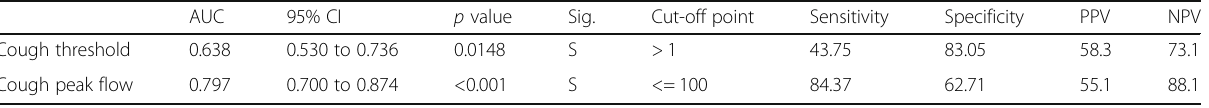
Table 4 ROC curve for threshold and peak flow of cough challenge